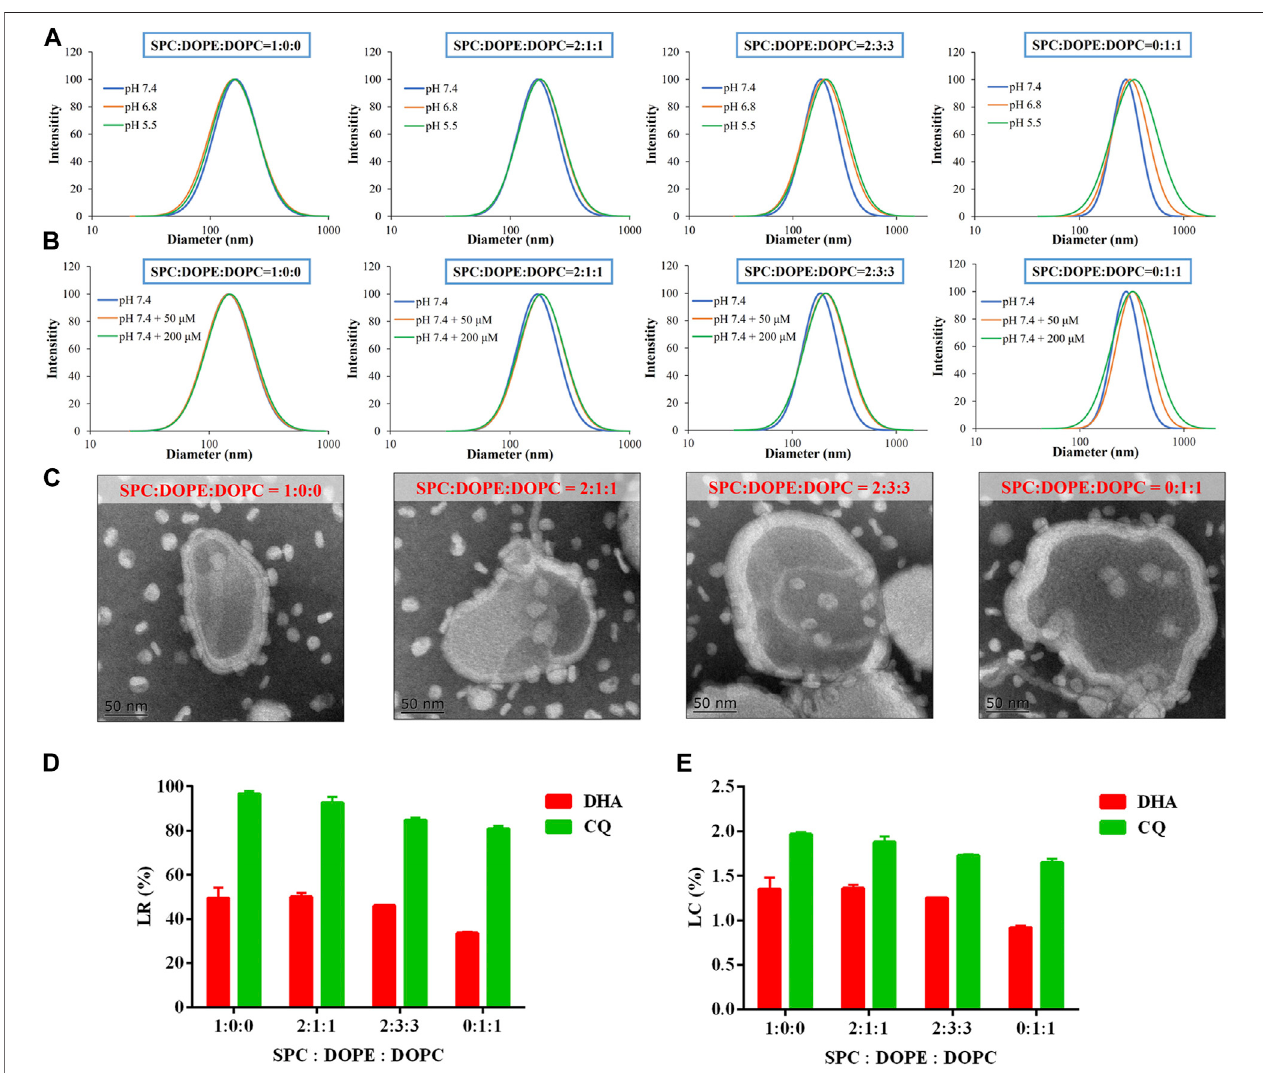
FIGURE1| PreparationandoptimizationofLNP/DCwithrespecttoSPC/DOPE/DOPCratio. (A,B) SizedistributionofLNP/DCpreparedatvarious weightratioof SPC/DOPE/DOPCinpH7.4,6.8,5.5 (A) andpH7.4+50/200 μ M-H 2 O 2 (B) medium. (C) TEMimagesofLNP/DCpreparedatvariousweightratioofSPC/DOPE/DOPC (Scarbarreads50 µm). (D) LRand (E) LCofDHAandCQforLNP/DCpreparedatvariousweightratioofSPC/DOPE/DOPC.Eachbarrepresentsthemean ± SD( n (cid:1) 3).